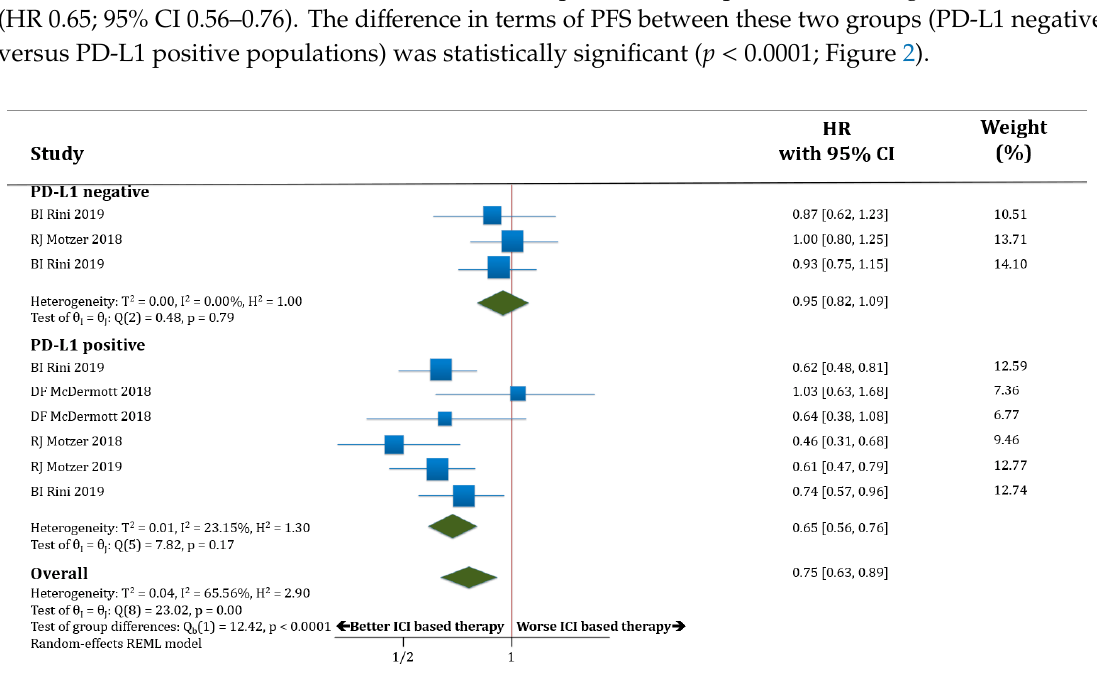
Figure 2. Forest plot diagram: hazard ratio (HR) with 95% confidence interval of progression-free survival (PFS) between arms according to programmed death-ligand 1 (PD-L1) expression subgroups.